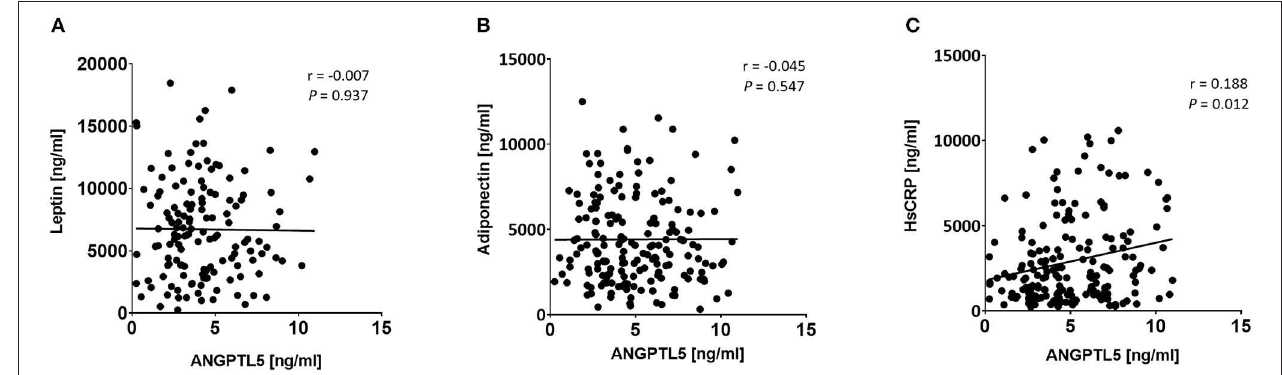
FIGURE 7 | Spearman’s correlation analysis of ANGPTL5 levels and obesity markers including leptin (A) , adiponectin (B) , and HsCRP (C) . P < 0.05 was considered significant as determined by Spearman’s correlation. of lipoprotein lipase and lipid metabolism regulation